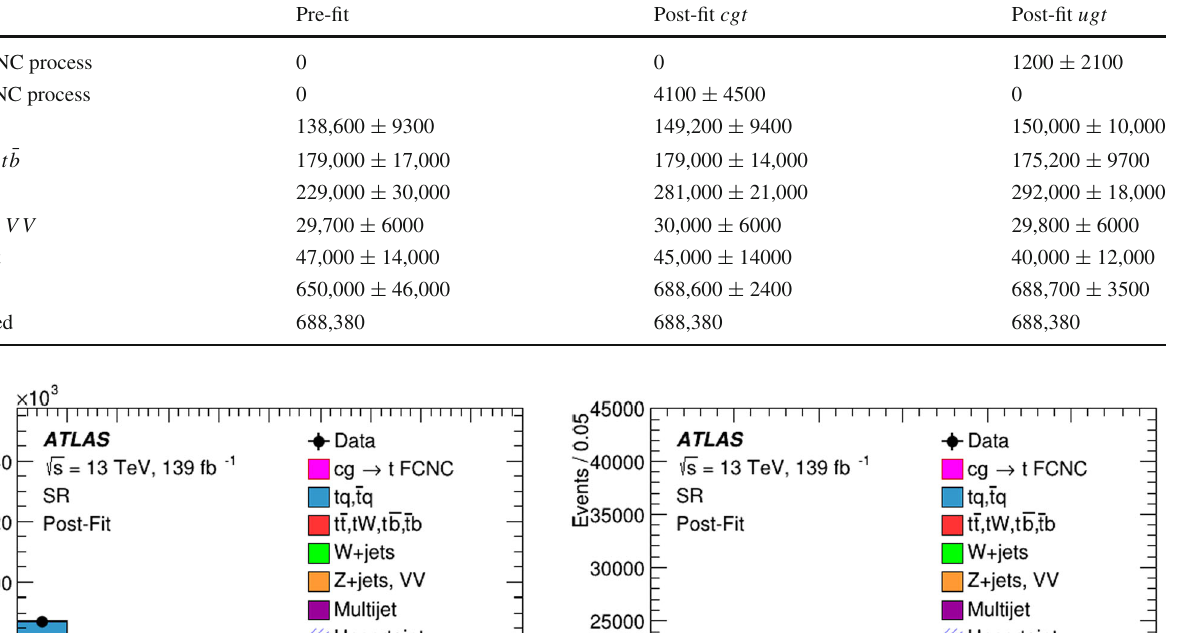
Table 3 Expected pre-fit and post-fit event yields along with the observed event yield in the SR. The quoted uncertainties include the statistical and systematic uncertainties of the event yields. Correlations,